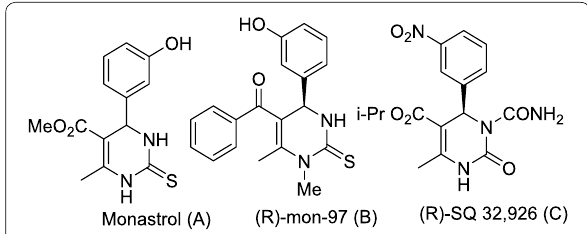
Fig. 2 Representative natural products DHPMs-containing